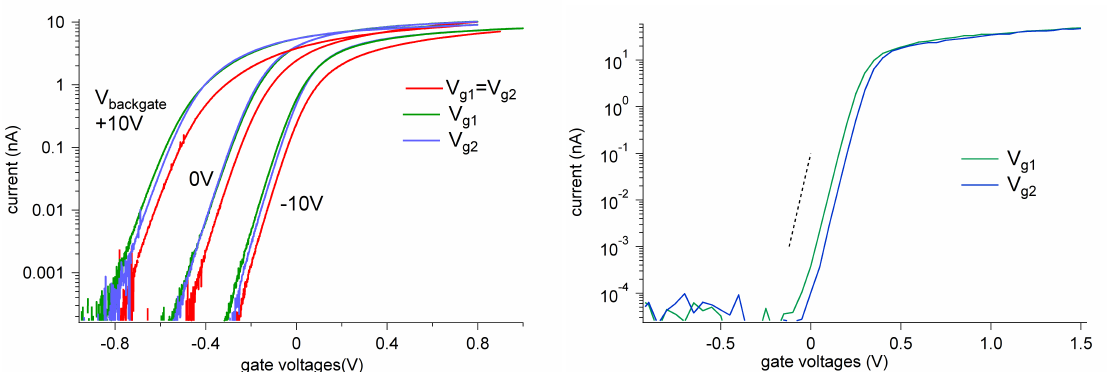
Figure 8. Left : Drain-Source current versus gate voltages at 300K and at three values of the backgate voltage in a two-gate electron pump. For the red curves the two gates are swept together. For the blue and green curves one gate is swept while the other one is kept at +0.8V. The sub-threshold slope measured here is ≈ 90mV/decade. The degradation compared to the ideal value of 60mV/decade at 300K is mostly due to the thick silicon layer (T Si = 20nm); Right : Same data (except for the two gates at the same voltage, not shown) at zero backgate voltage in a device with very good electrostatic control (slope of 68mV/decade) thanks to a much thinner silicon layer (T Si = 11nm). The black dashed line shows the ideal slope of